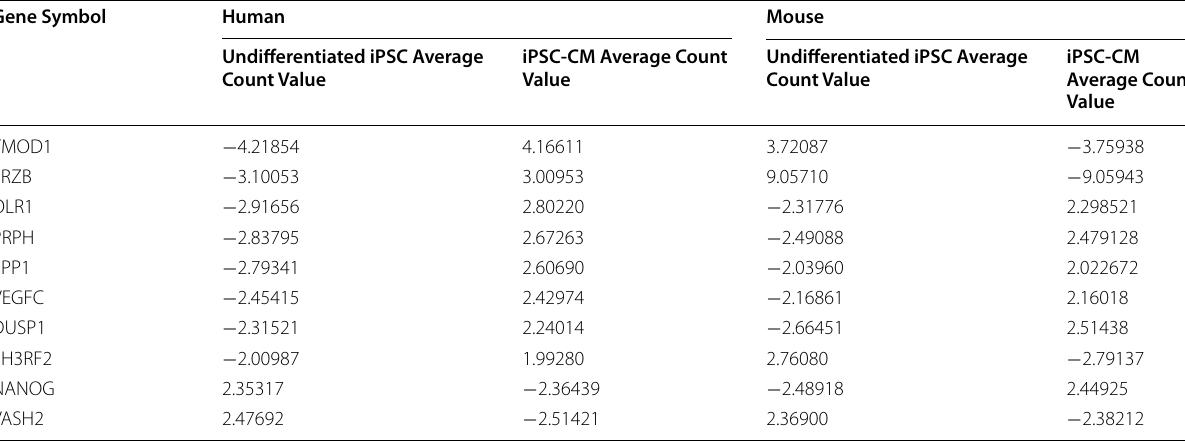
Table 2 The shared DEGs between the humans and mouse data